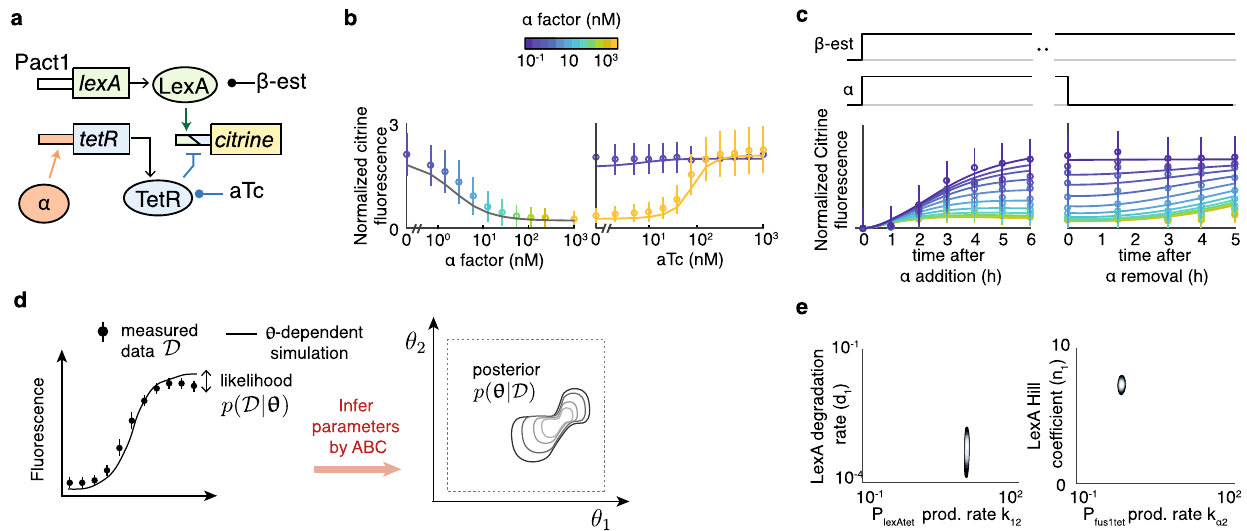
Fig. 3 Rapid prototyping. a Example module for characterization (strain yCL109; β -est: β -estradiol; aTc: anhydrotetracyclin). b , c Characterization experiments, citrine fl uorescence measured by fl ow cytometry. All fl ow cytometry measurements include at least 4000 cells after gating. Symbols show experimental means, ±standard deviation, and lines simulations of the maximum likelihood parameter set estimated with all seven modules. 5 μ M β -estradiol were added at time 0, together with varying concentrations of α -factor (dose response at 18 h ( b ), dynamics after α addition ( c )), or varying concentrations of aTc with 0 or 1 μ M α (aTc dose response at 6 h ( b )). For α -factor release ( c ), we removed α from the medium 18 h after induction. d Illustration of the second step of TopoDesign to infer the posterior distribution p ð θ j D Þ of the 20 parameters θ i for parts in Fig. 1b by approximate Bayesian computation (ABC) using the likelihood p ð D j θ Þ for data D . e Projection of the joint posterior parameter distribution on two pairs of parameters; bright contour lines indicate high probability density.